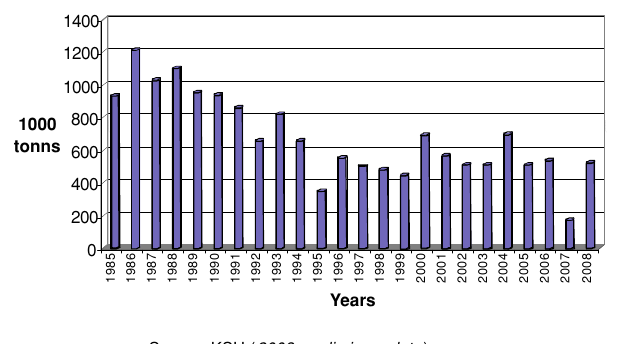
Figure 3: Apple production of Hungary during the period 1985–2008 (thousand